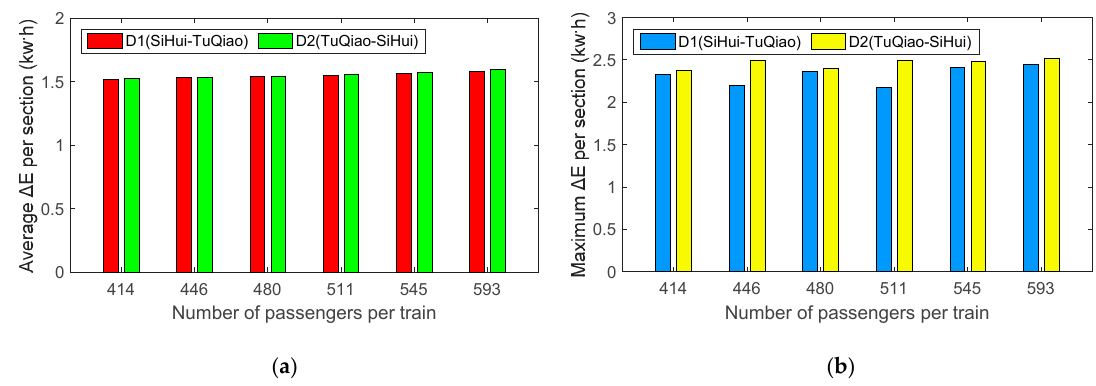
Figure 15. Statistical results of average energy saving rate per section from the weekday timetable. ( a ) Comparison of average results; ( b ) Comparison of maximum results.